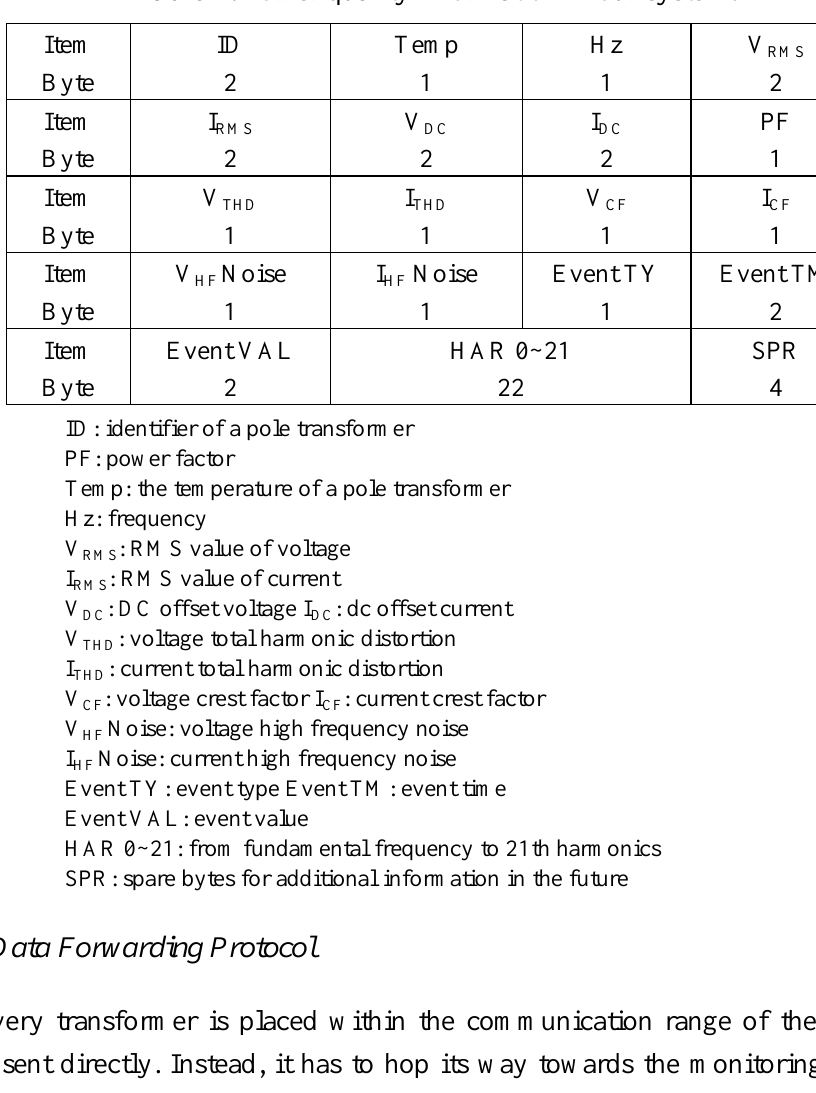
Table 1. Power quality information in our